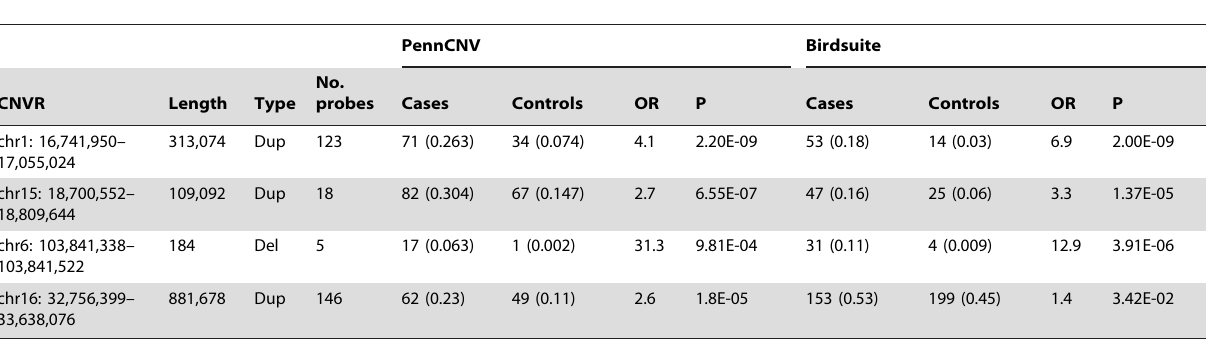
Table 2. Multivariate regression model of association of three top CNVRs with BAVM.